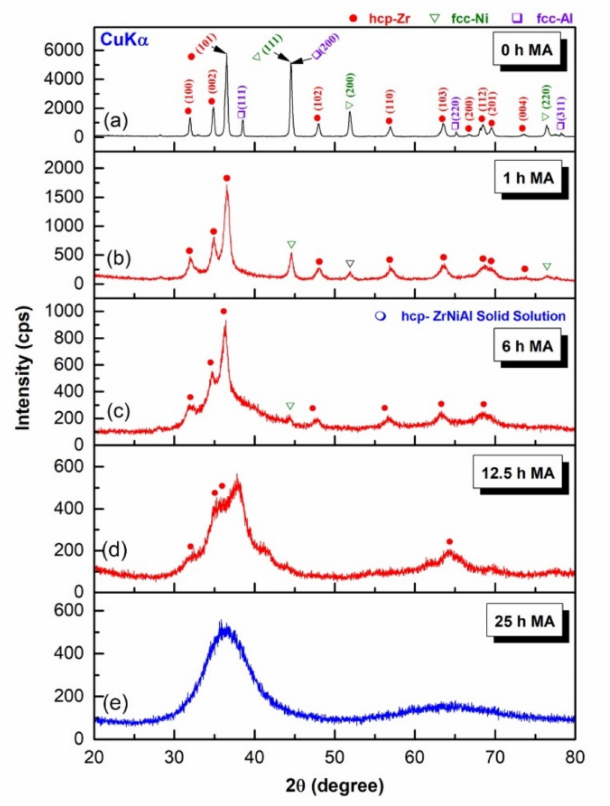
Figure 1. XRD patterns of MA-Zr 75 Ni 25 Al 5 powders obtained after HEBM for ( a ) 0, ( b ) 1, ( c ) 6, ( d ) 12.5, and ( e ) 25